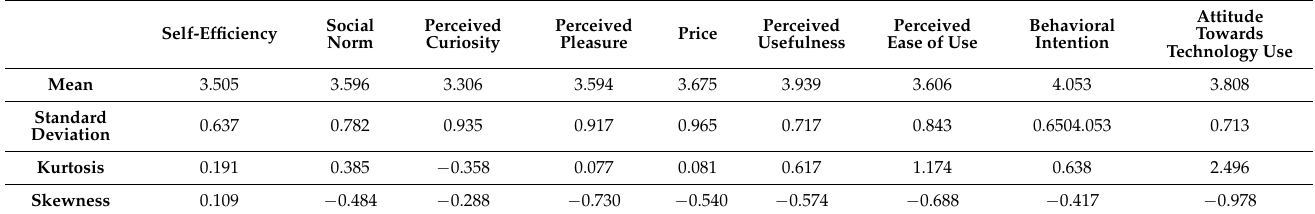
Table 3. Descriptive statistics for